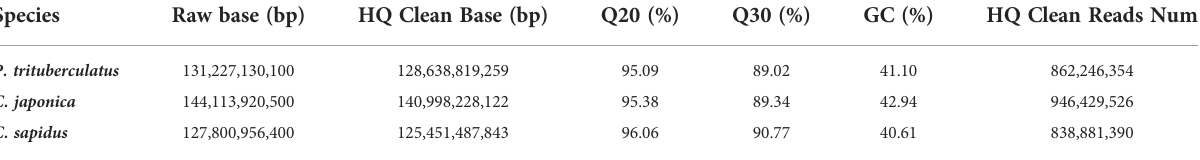
TABLE 1 Sequencing data statistics for three crab species.